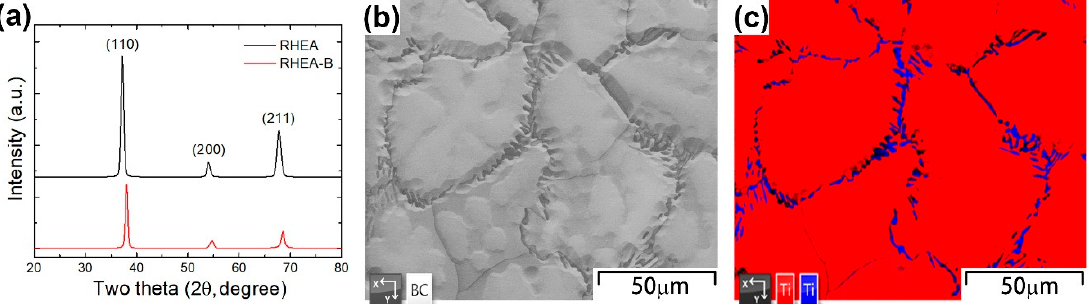
Figure 1. ( a ) XRD patterns of RHEA and RHEA-B samples; ( b ) SEM image and ( c ) EBSD phase map of RHEA-B sample (red: BCC; blue: HCP; standard: the phases of Ti element).